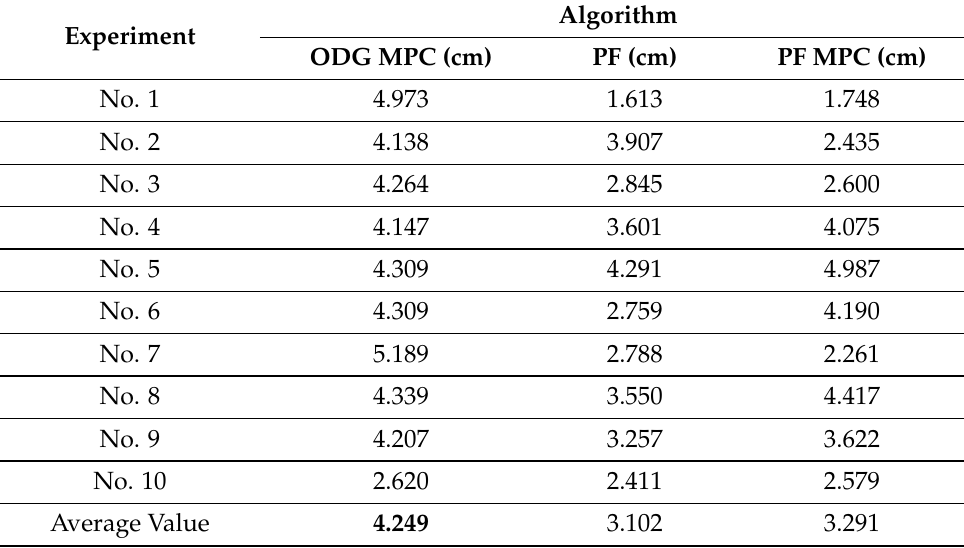
Table 9. Results of the minimum distance from Scenario 2 for a dynamic